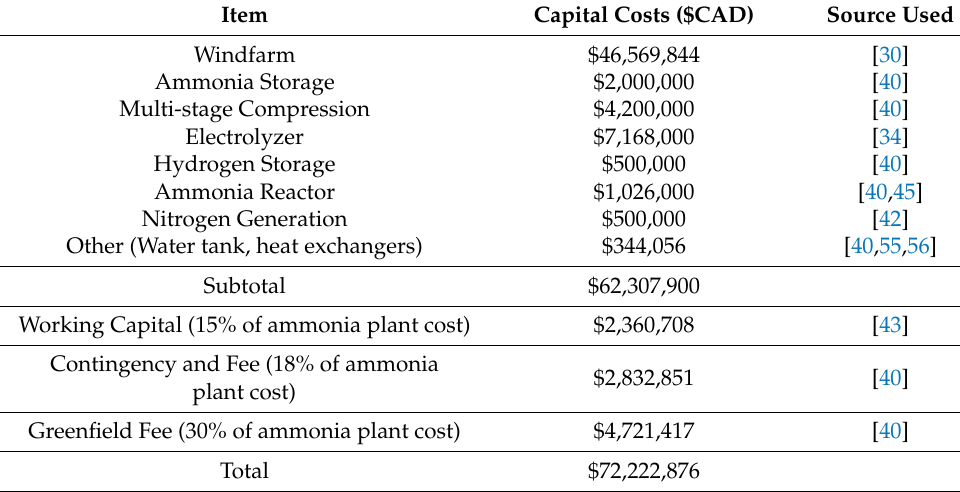
Table 5. CAPEX summary for the P2A system